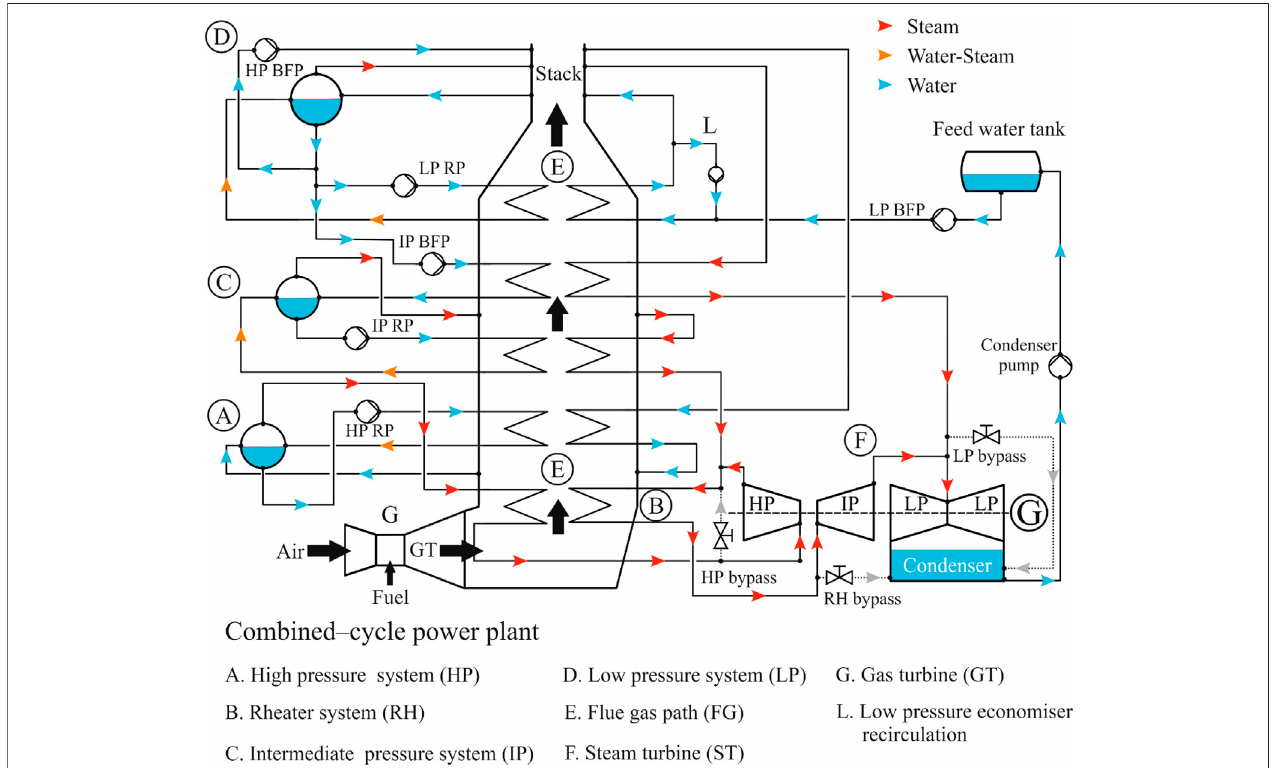
FIGURE3| SchematicdiagramofamodernCCPPincluding1+1arrangementofgasturbineandsteamturbineunitsincombinationwithatriple-pressure,reheat, vertical heat recovery steam generator (source Alobaid et al., 2008).